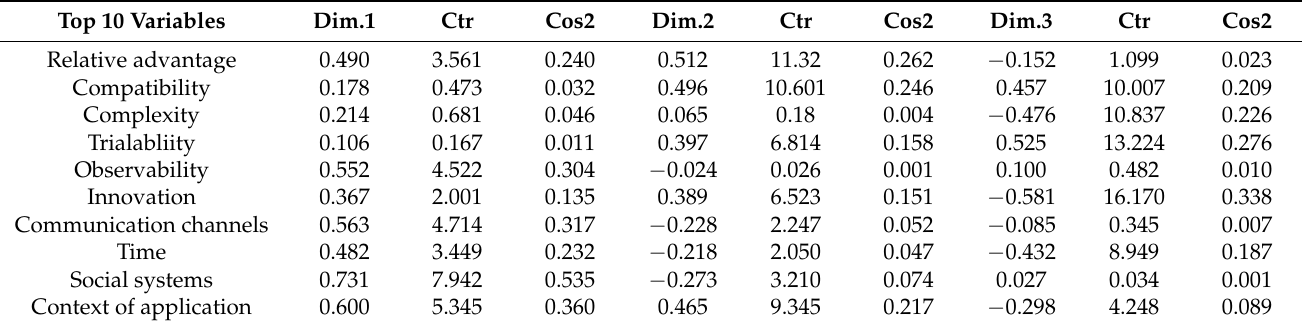
Table 2. Contribution and cos2 for the first three dimensions for the top ten variables.